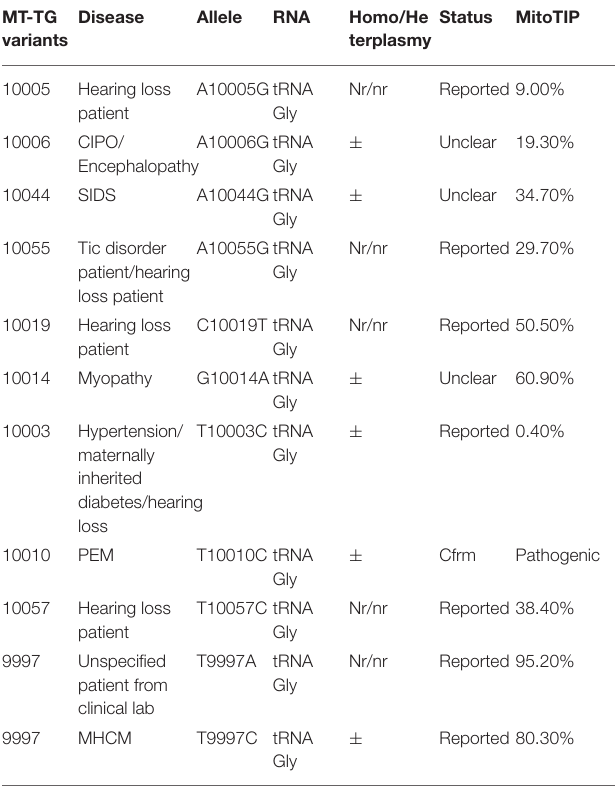
TABLE 1 | 11 MT-TG variants reported in